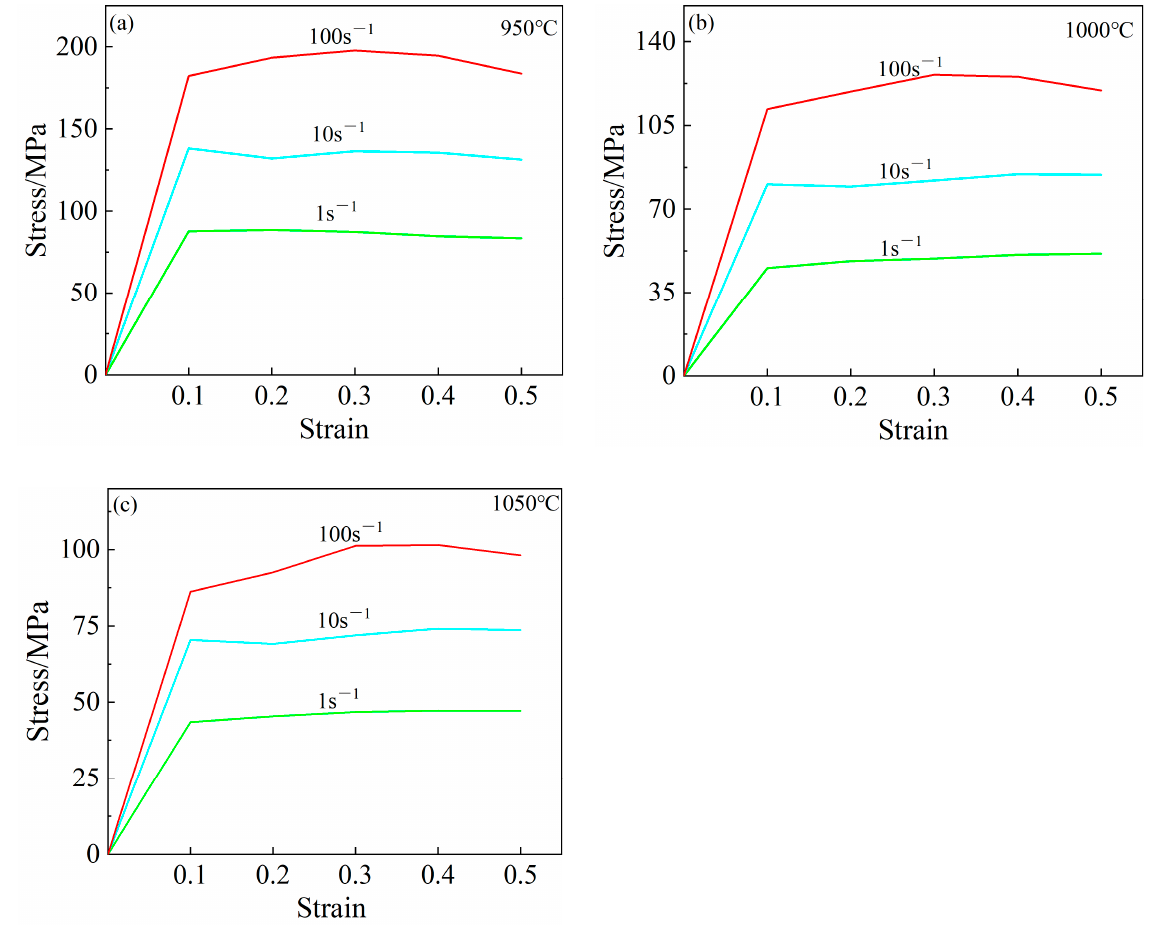
Figure 3. Flow curves of TC4ELI at different temperatures: ( a ) 950 °C; ( b ) 1000 °C and ( c ) 1050 °C.